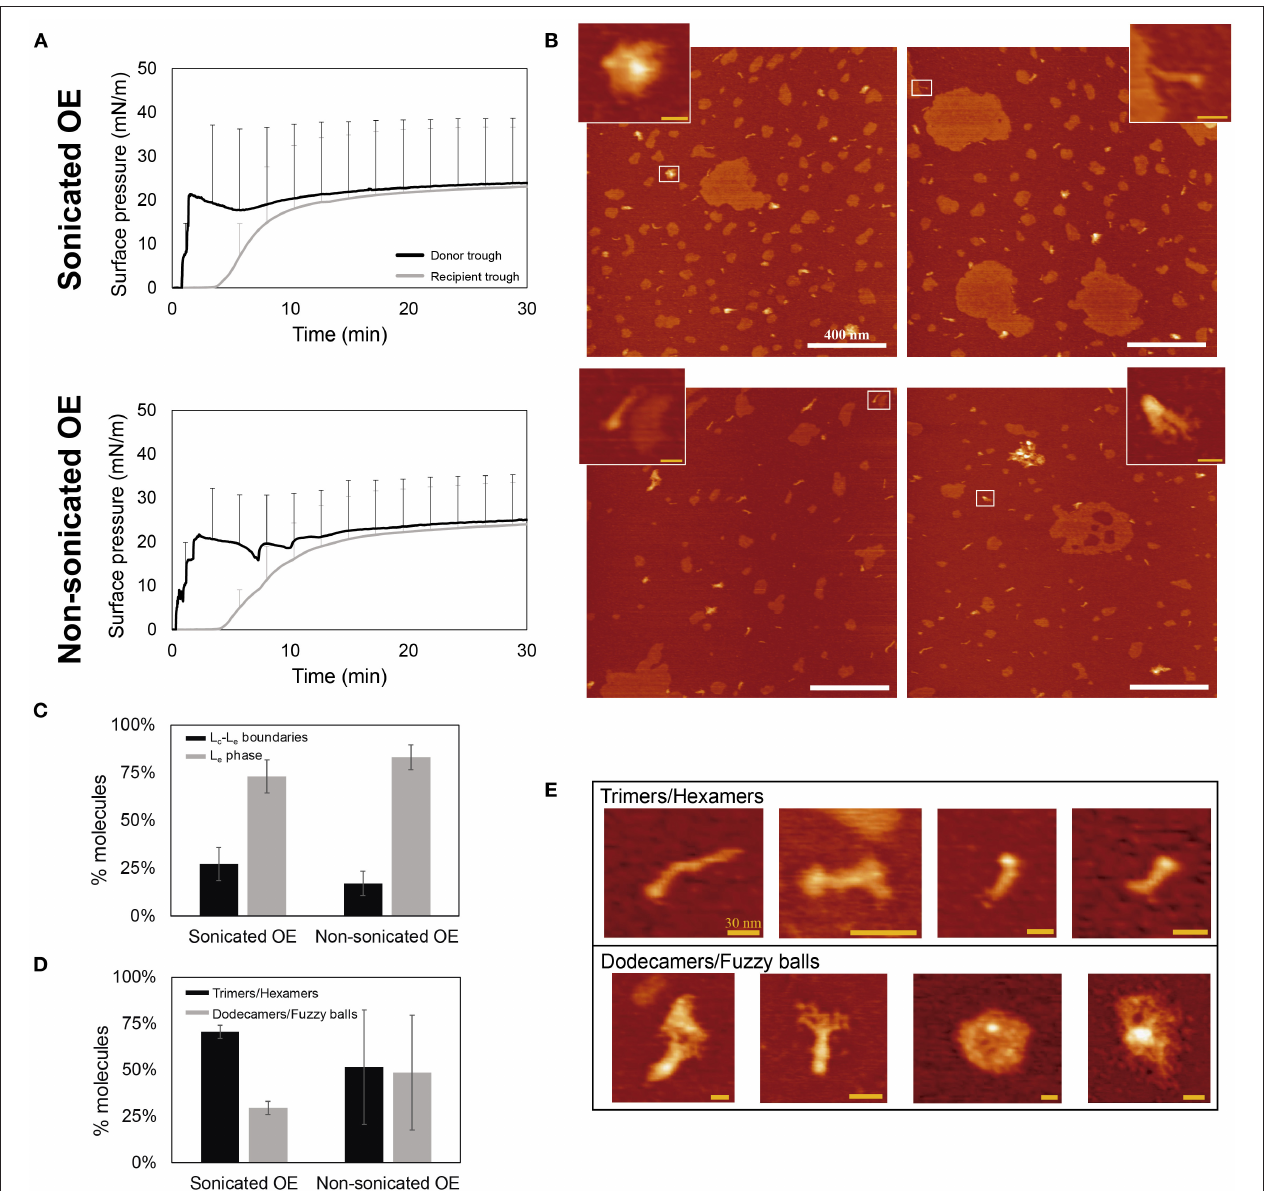
FIGURE 5 | Analysis of rhSP-D oligomers transported over the air-liquid interface associated to surfactant complexes. An aqueous aliquot of OE/rhSP-D at 50 mg/mL (750 µ g) and 1% rhSP-D by mass (7.5 µ g) was applied at the donor interface. (A) Adsorption and spreading isotherms performed in the double-Langmuir balance. (B) AFM height images taken after transference onto mica surface of the recipient interfacial film. Data obtained by the vehiculization of sonicated (top) or non-sonicated (bottom) OE before mixing with 1% w/w rhSP-D. Scale bar: 400nm. Zoom regions show examples of rhSP-D oligomers corresponding to the areas highlighted with white rectangles. Scale bar: 30nm. (C) Percentage of rhSP-D oligomers found at the L c -L e boundaries (black) or distributed into the L e phase (gray) upon vehiculization by sonicated or non-sonicated surfactant. (D) Quantitative distribution of smaller and larger rhSP-D oligomers observed in surfactant films, upon association of the protein with sonicated or non-sonicated surfactant structures. (E) Representative AFM images of the different SP-D oligomers grouped into trimers/hexamers and dodecamers/fuzzy balls. Scale bar: 30nm.